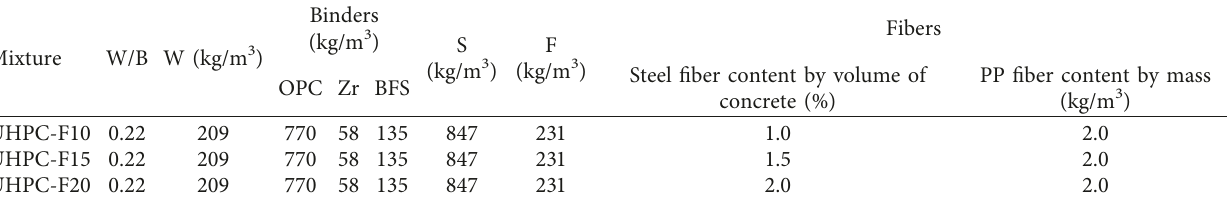
Figure 1: (a) Steel fibers and (b) polypropylene fibers used for the UHPC. Table 1: Mixing proportion of the UHPC.